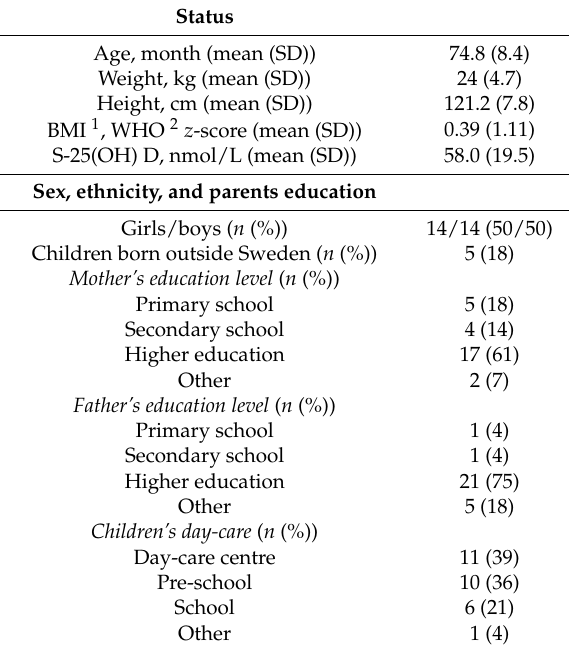
Table 1. Baseline characteristics of 28 5–7-year-old children in a validation study of a short food frequency questionnaire assessing vitamin D and calcium